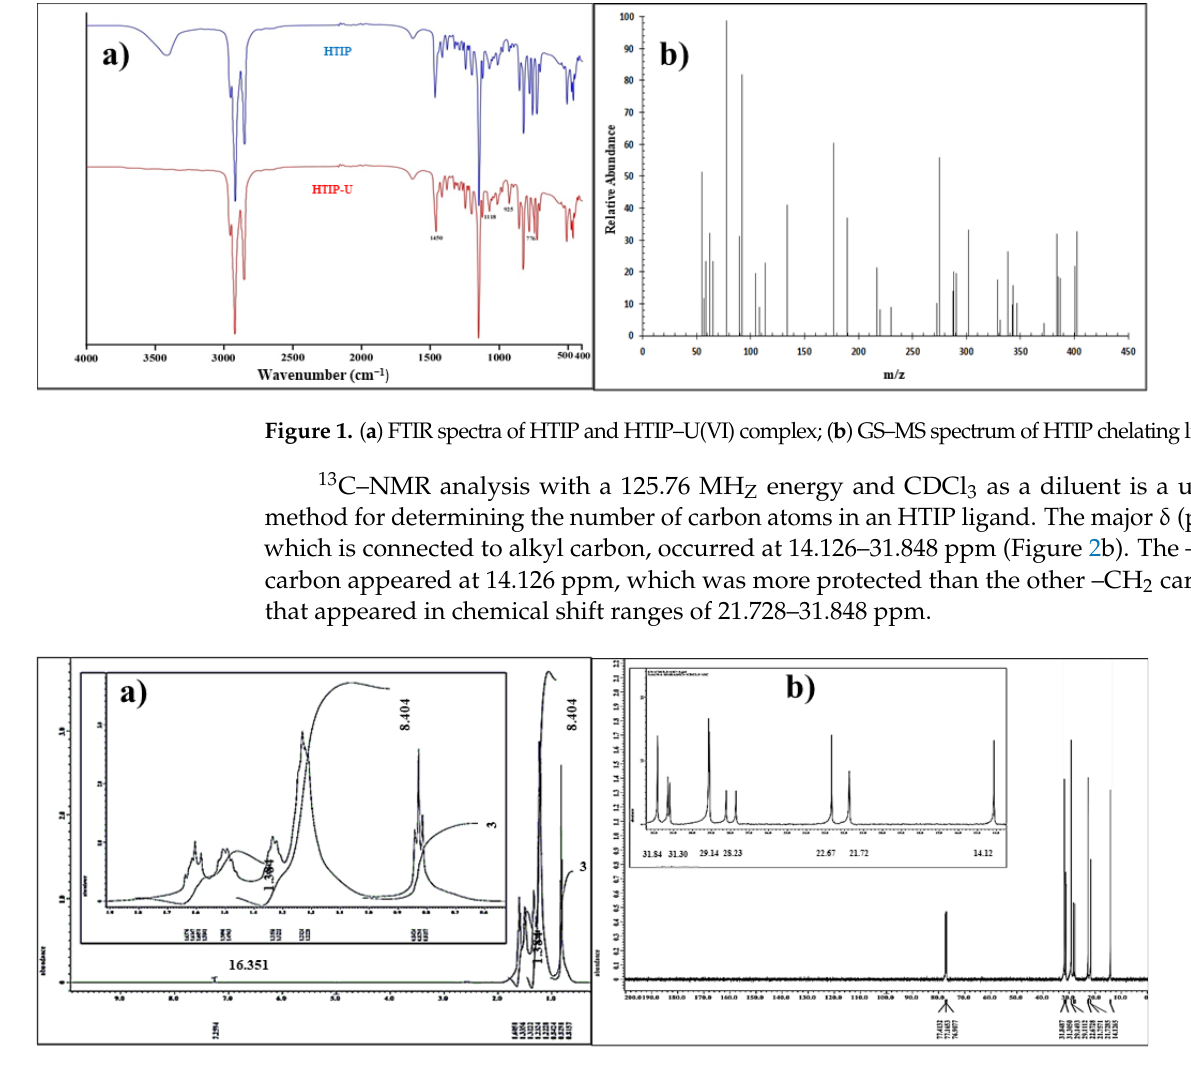
Figure 2. ( a ) 1 H–NMR spectrum; ( b ) 13 C–NMR spectrum of HTIP chelating ligand.